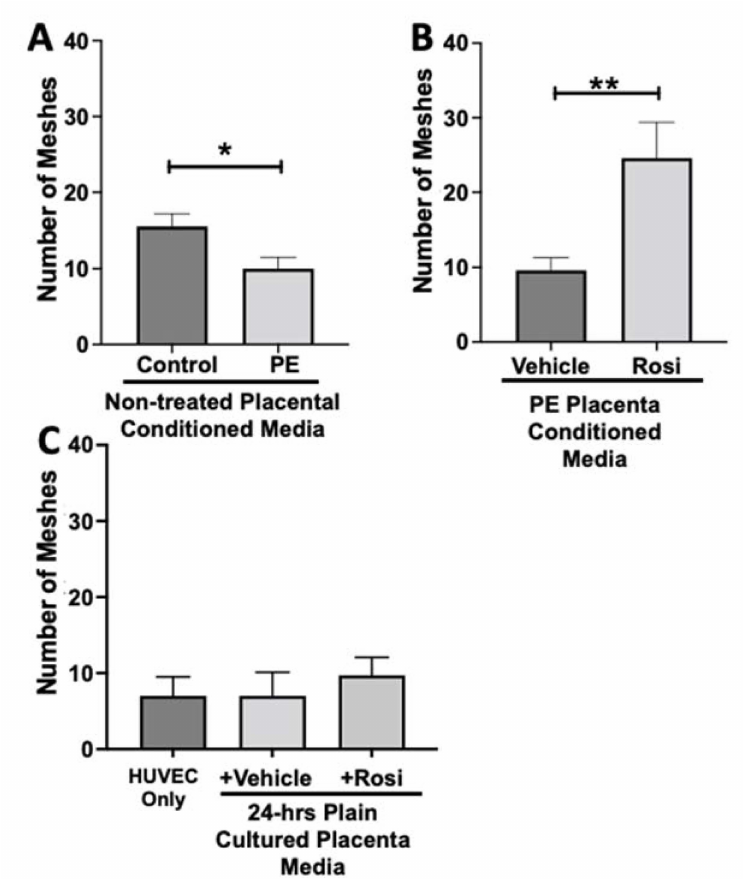
Figure 13. There is a reduction of the total number of meshes present in HUVECs from culture with conditioned media from preeclamptic placentas, but this was significantly increased after culture with Rosiglitazone-treated preeclamptic placentas. HUVECs were cultured with conditioned media on matrigel, and the number of meshes was calculated by the Image J Angiogenesis Analyzer tool